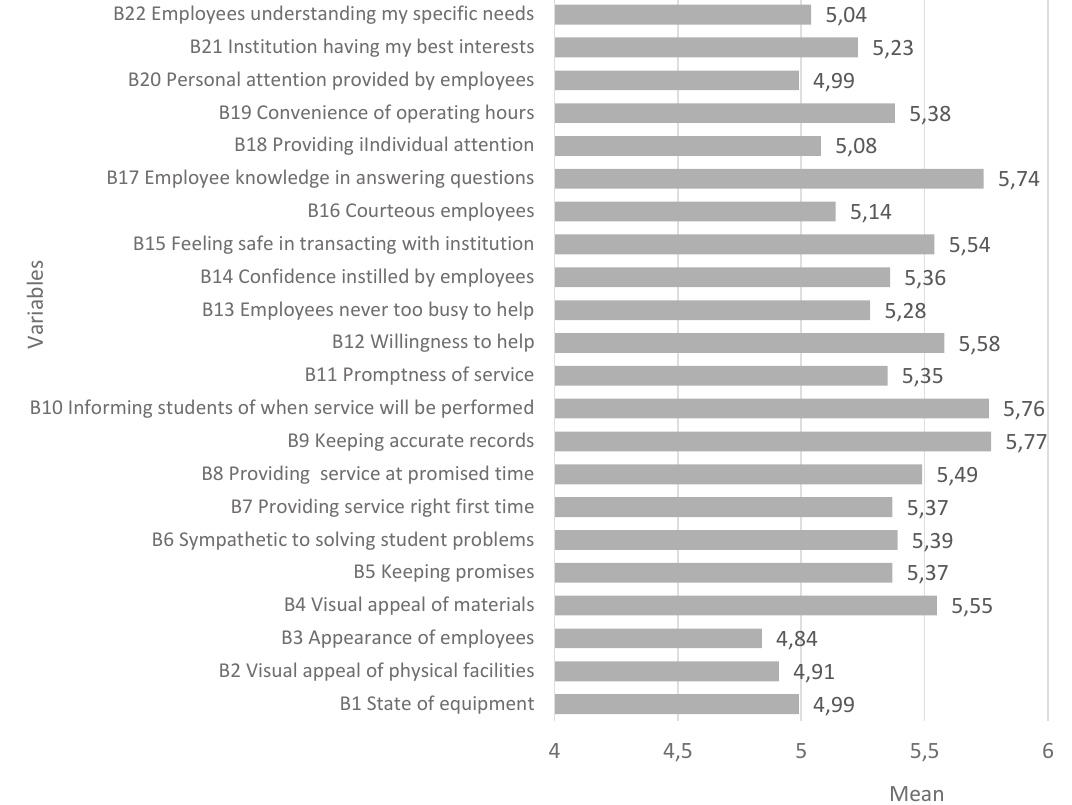
Figure 3. Mean importance ratings of service quality variables